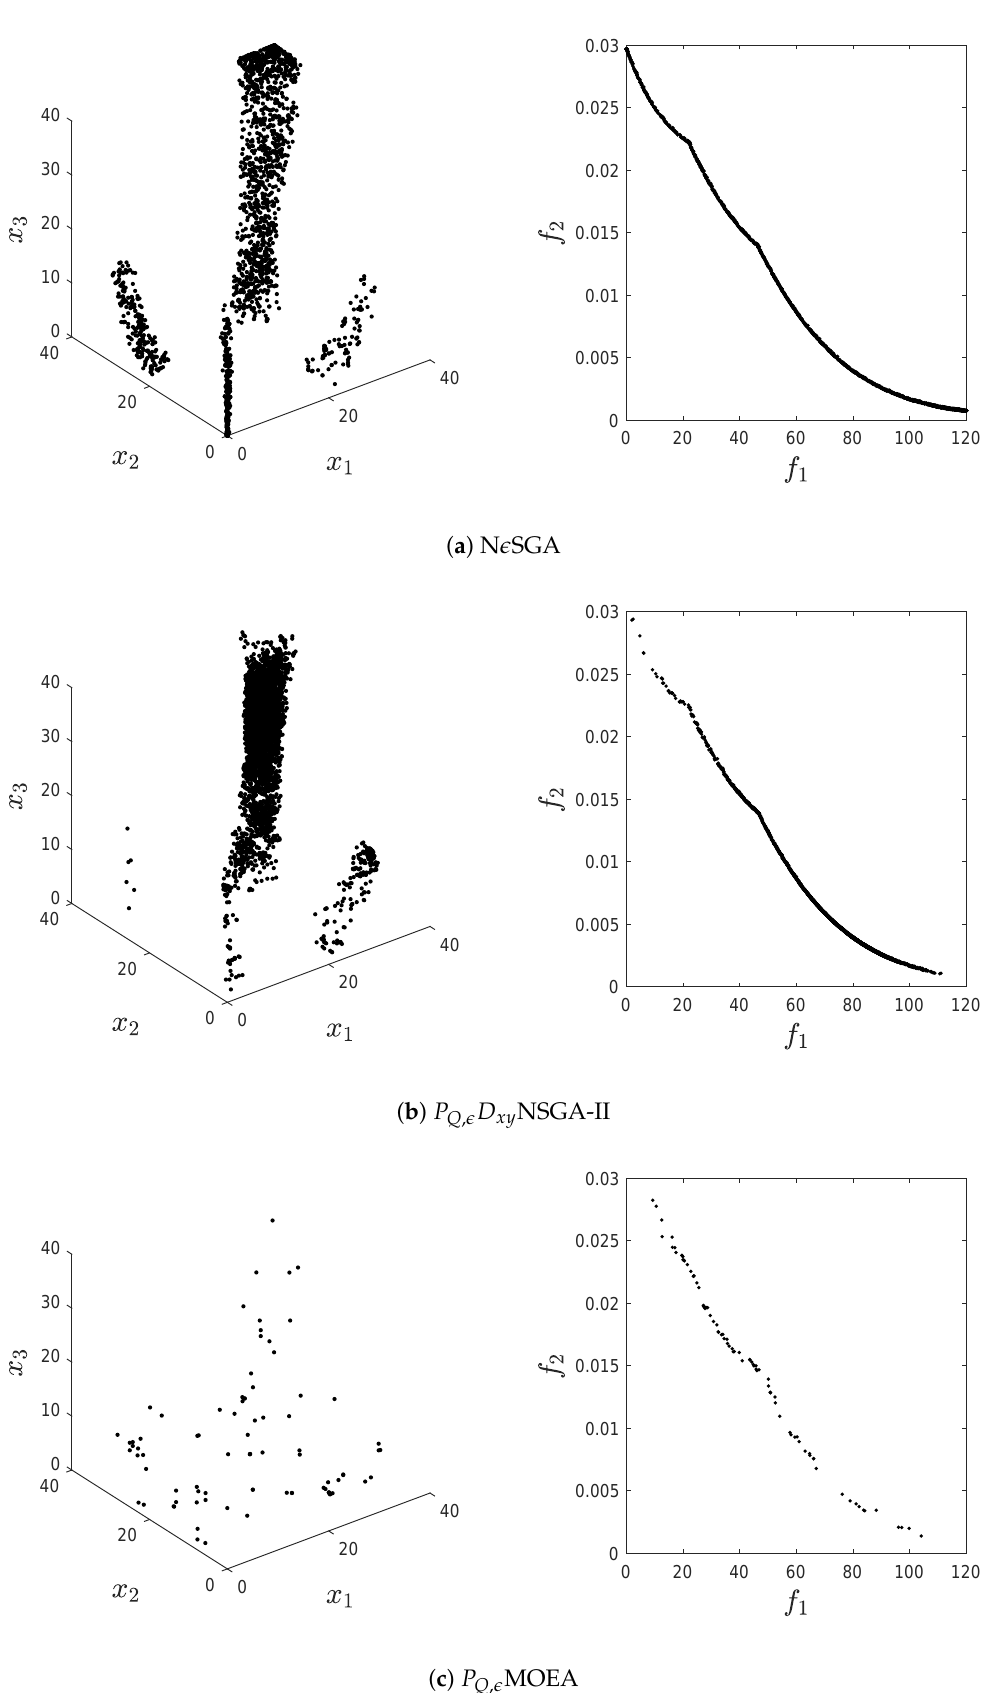
Figure 5. Numerical results on SSW for the comparison of N e SGA2 and the state-of-the-art algorithms.